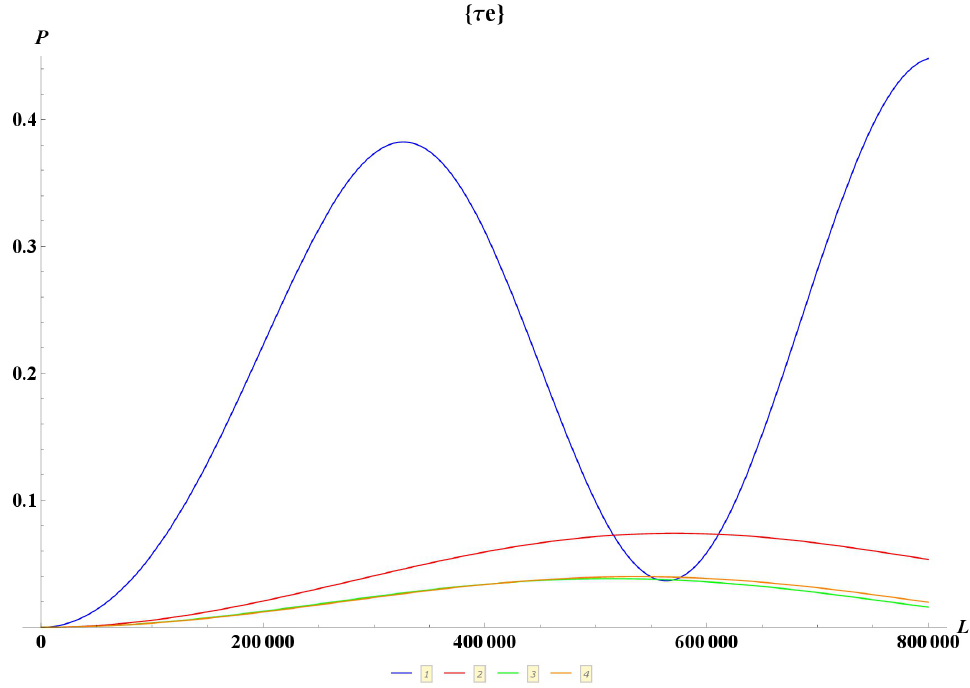
Figure 10. Same analysis of Figure 8, but for P ν